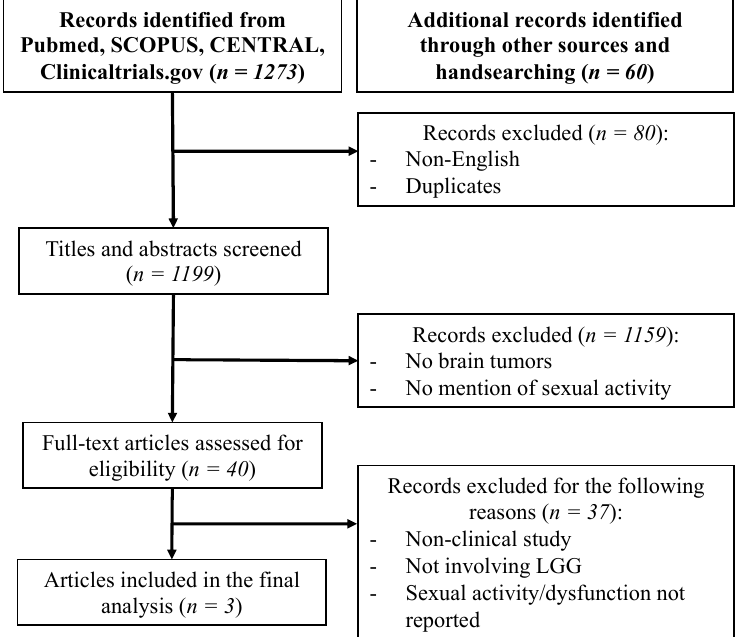
Figure 1. PRISMA flow diagram for study selection. From the 1273 articles identified in the four databases, 1199 were screened for titles and abstracts. Articles which did not concern brain tumors and/or sexual activity were excluded. From 40 articles assessed for eligibility, 37 were excluded due absence of LGG patients and/or report of sexual activity, or if the article was not a clinical study (e.g., case report). Finally, 3 studies were included for analysis.